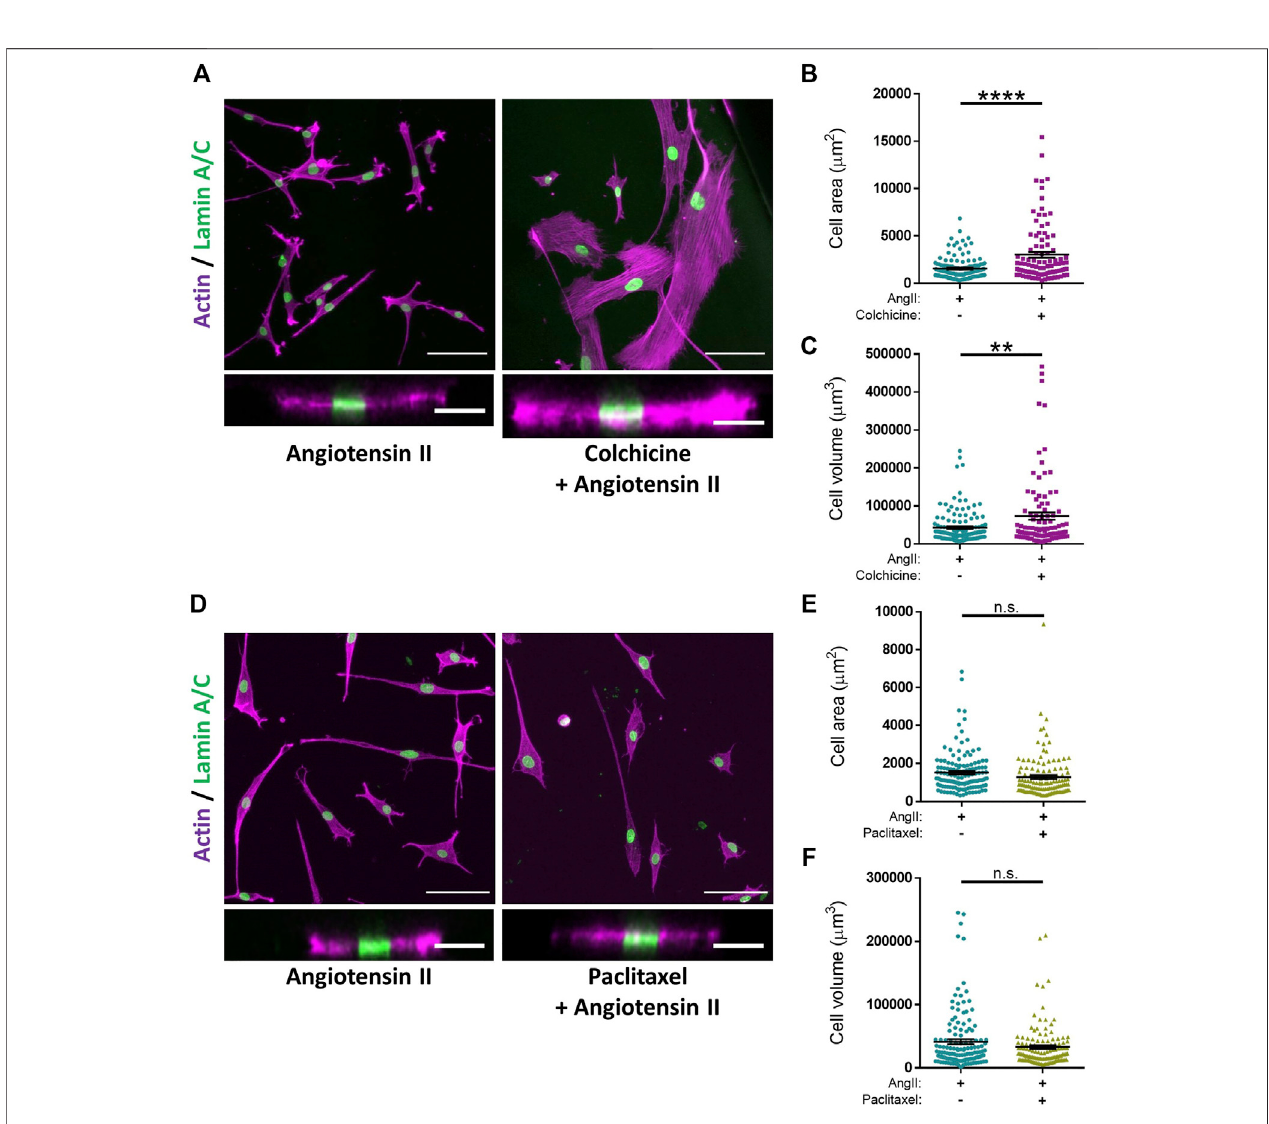
FIGURE 5 | Microtubule destabilisation alters angiotensin II stimulated VSMC volume on pliable hydrogels. (A) Representative images of isolated VSMCs cultured on12 kPapolyacrylamidehydrogelspre-treated +/ − colchicine(100 nM)for30 minpriortocotreatmentwithangiotensin II(AngII)(10 µM)foranadditional30 min.Actin cytoskeleton(purple)andLaminA/C(green).Top — RepresentativeXYimagesofVSMCarea.Scalebar=100 μ m.Bottom — RepresentativeXZimagesofVSMCheight. Scalebar=30 μ m. (B) IsolatedVSMCareaand (C) IsolatedVSMCvolume.Both B&C arerepresentativeof3independentexperimentswith ≥ 100cellanalysedper condition. (D) Representative images of isolated VSMCs cultured on 12 kPa polyacrylamide hydrogels pre-treated +/ − paclitaxel (1 nM) for 30 min prior to cotreatment withangiotensinII(AngII)(10 µM)foranadditional30 min.Actincytoskeleton(purple)andLaminA/C(green).Top — RepresentativeXYimagesofVSMCarea.Scalebar= 100 μ m. Bottom — Representative XZ images of VSMC height. Scale bar = 30 μ m. (E) Isolated VSMCarea and (F) Isolated VSMCvolume. Both (E,F) are representative of 3 independent experiments with ≥ 125 cell analysed per condition. (n.s. = non-signi fi cant), (** = p < 0.01), (**** = p < 0.0001).